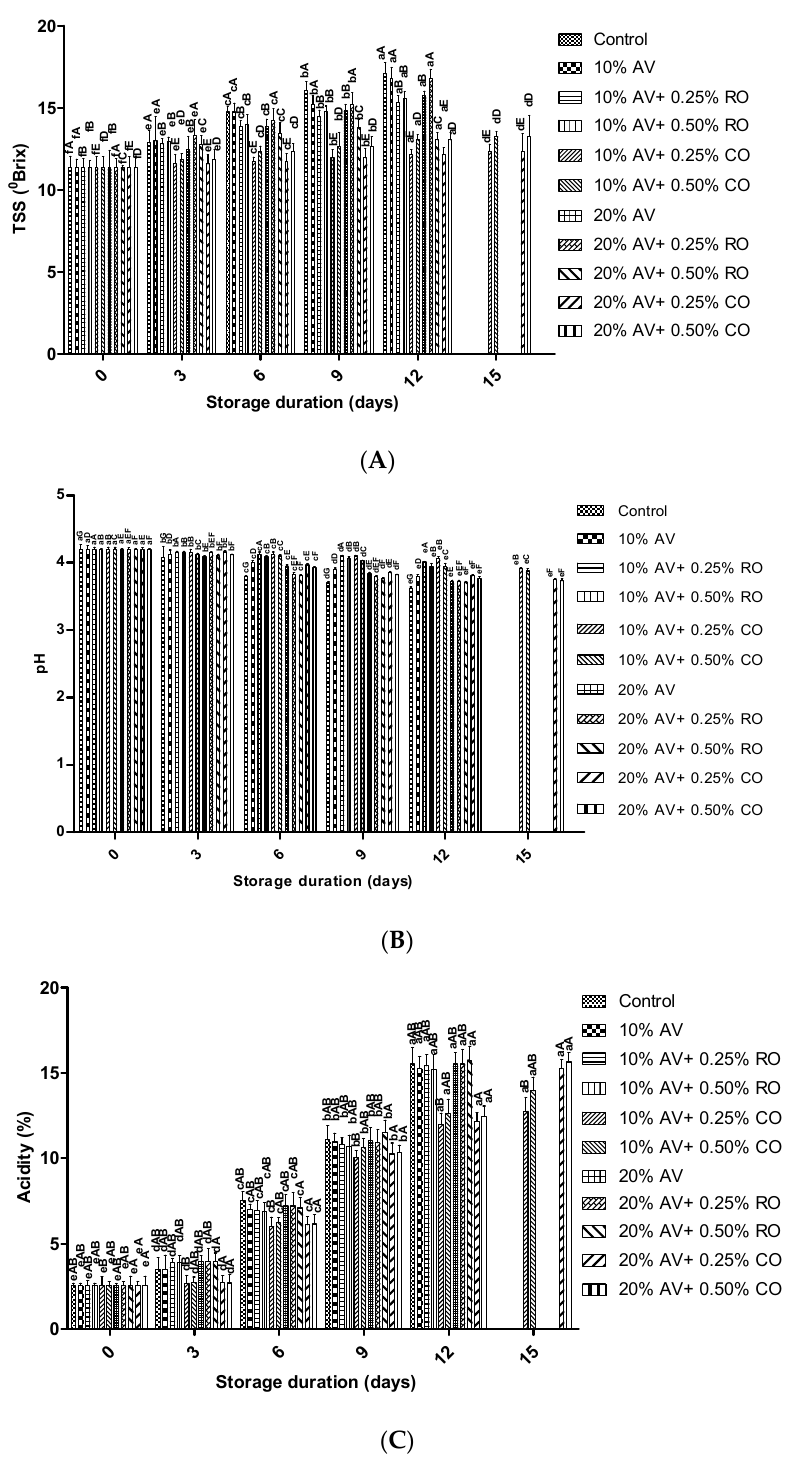
Figure 5. ( A ) TSS ( ◦ Brix), ( B ) pH, and ( C ) Titratable acidity (% citric acid equivalent) of ‘Bhagwa’ pomegranate arils that were coated with Aloe vera (AV) gel coatings that were enriched with rosehip oil (RO) (0.25% or 0.50%) and cinnamon oil (CO) (0.25% or 0.50%) and stored at 5 ± 1 ◦ C (95 ± 2% RH) for 15 days. The vertical bars represent the standard deviation (SD) of the mean values of three replicates (1 punnet = 1 replicate, n = 3). Values bearing at least one common small superscript (a, b, . . . , etc.) and at least one common capital superscript (A, B, . . . , etc.) letters differ significantly between the days and between the coating solution/concentrations, respectively, at p < 0.05 in Duncan’s multiple comparison post hoc test.